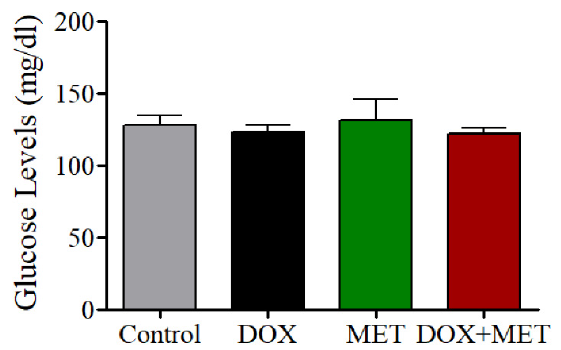
Figure 5. E ff ects of DOX and MET on rat blood glucose Figure 5. Effects of DOX and MET on rat blood glucose levels. Figure 5. Effects of DOX and MET on rat blood glucose levels.